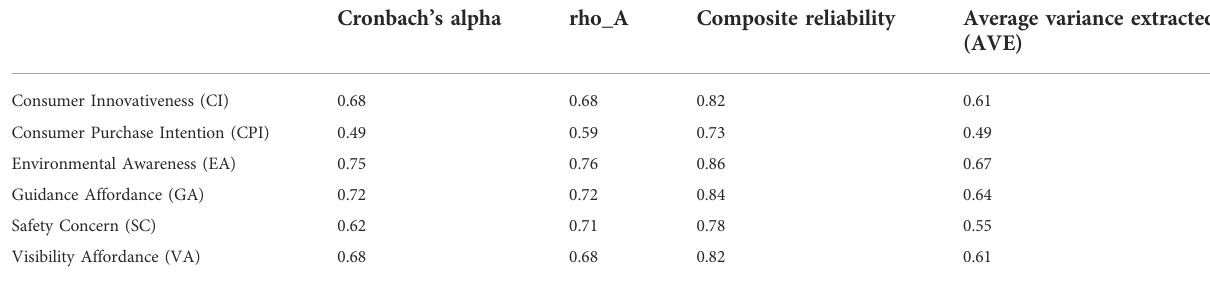
TABLE 3 Construct reliability and